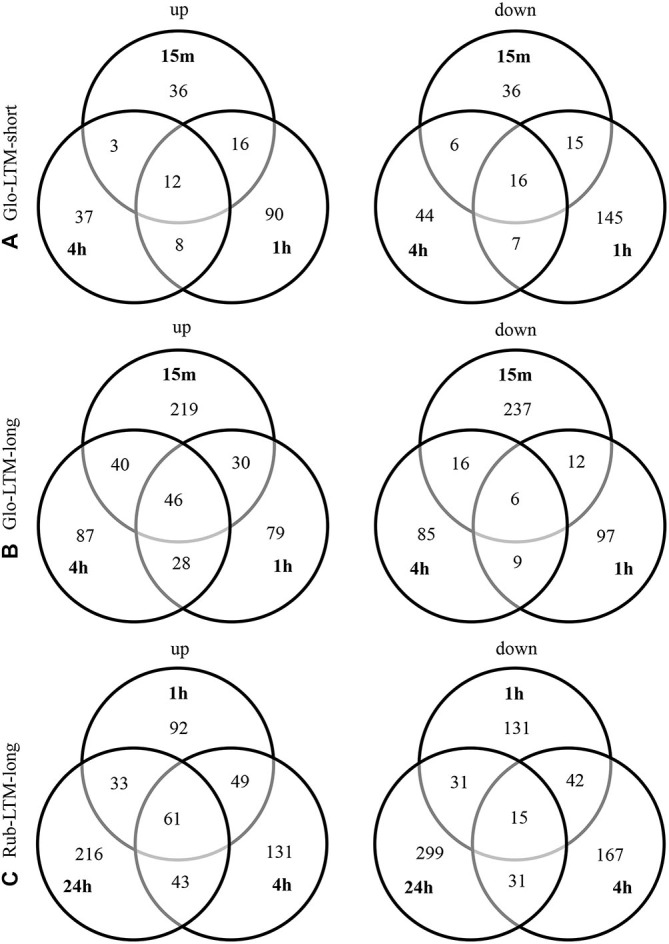
Venn diagrams of the up- and downregulated transcripts at each indicated time point in Glo-LTM-short (A), Glo-LTM-long (B) and Rub-LTM-long (C).